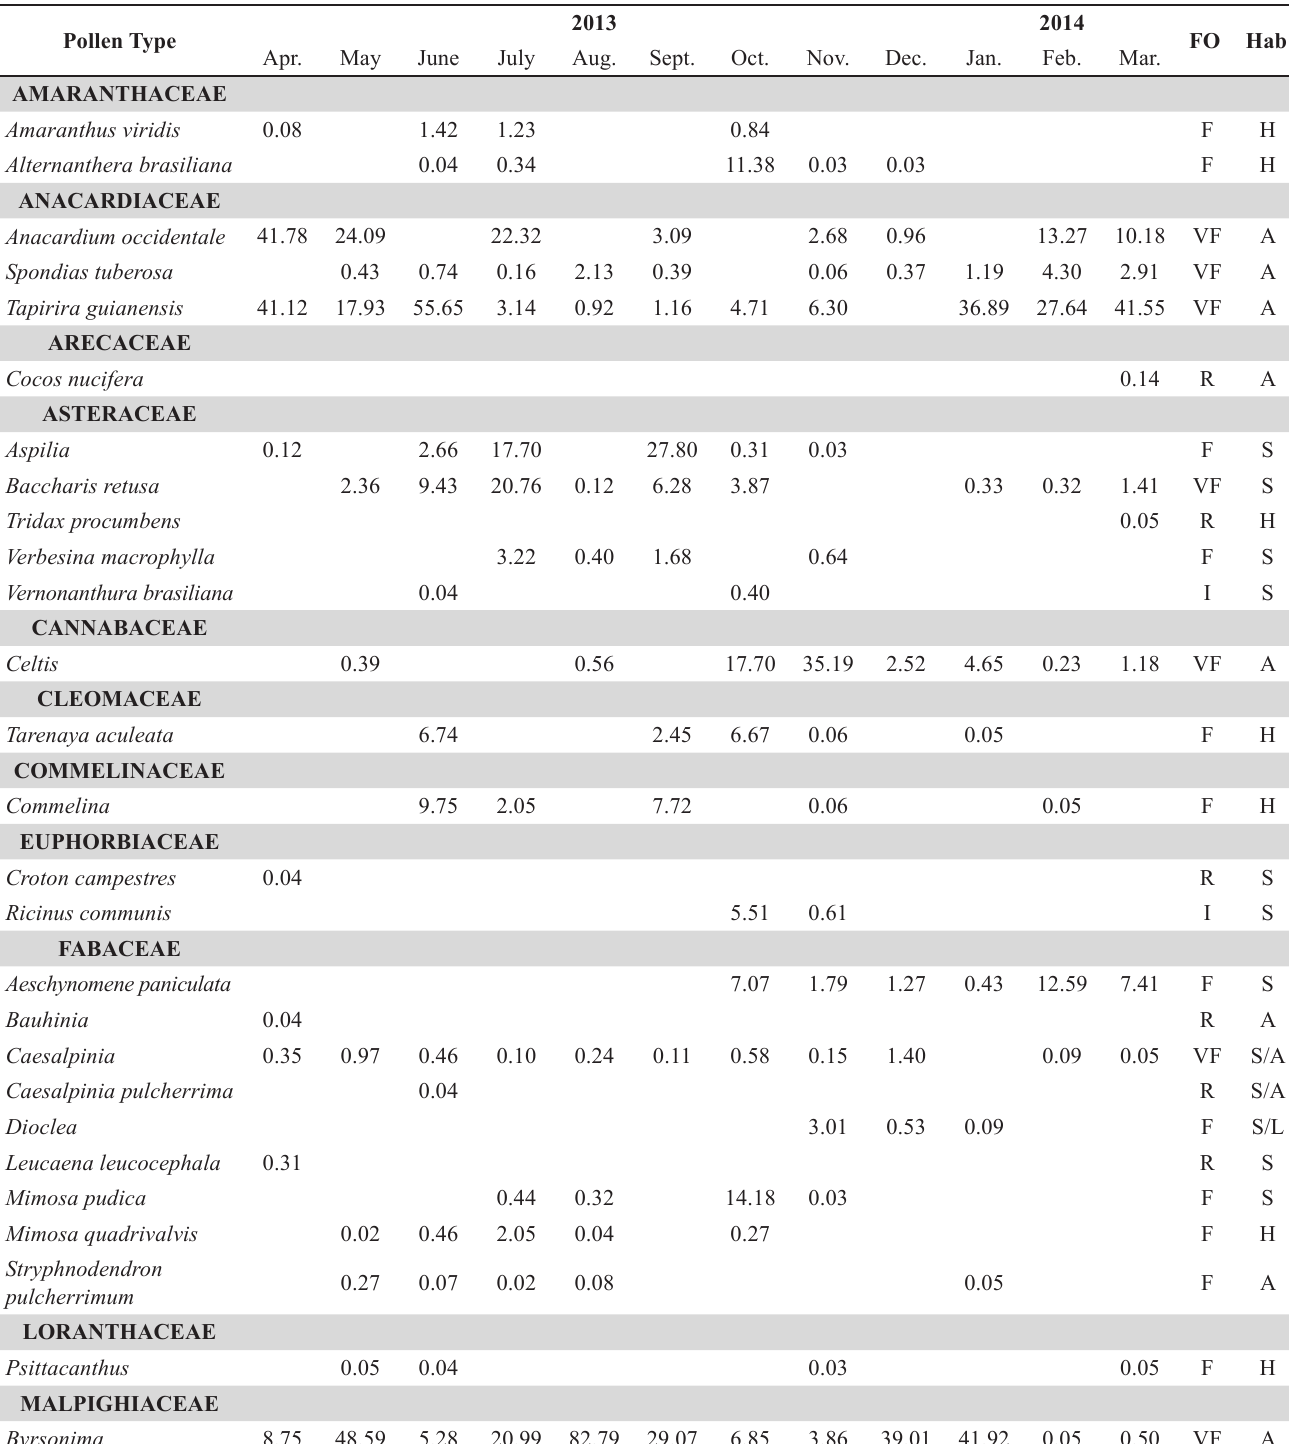
Table 1. Relative frequency (%) and classes of frequency of occurrence (FO) of pollen types occurring in pollen samples stored by Tetrago- nisca angustula (Latreille, 1811) in an Atlantic Forest area on the northern coast of Bahia. FO: Very Frequent (VF: > 50%), Frequent (F: 20% - 50%), Infrequent (I: 10% - < 20%) and Rare (R: < 10%). Habit (Hab) of plant species related to pollen types – A = Arboreal; S = Shrubby; H = Herbaceous; L =